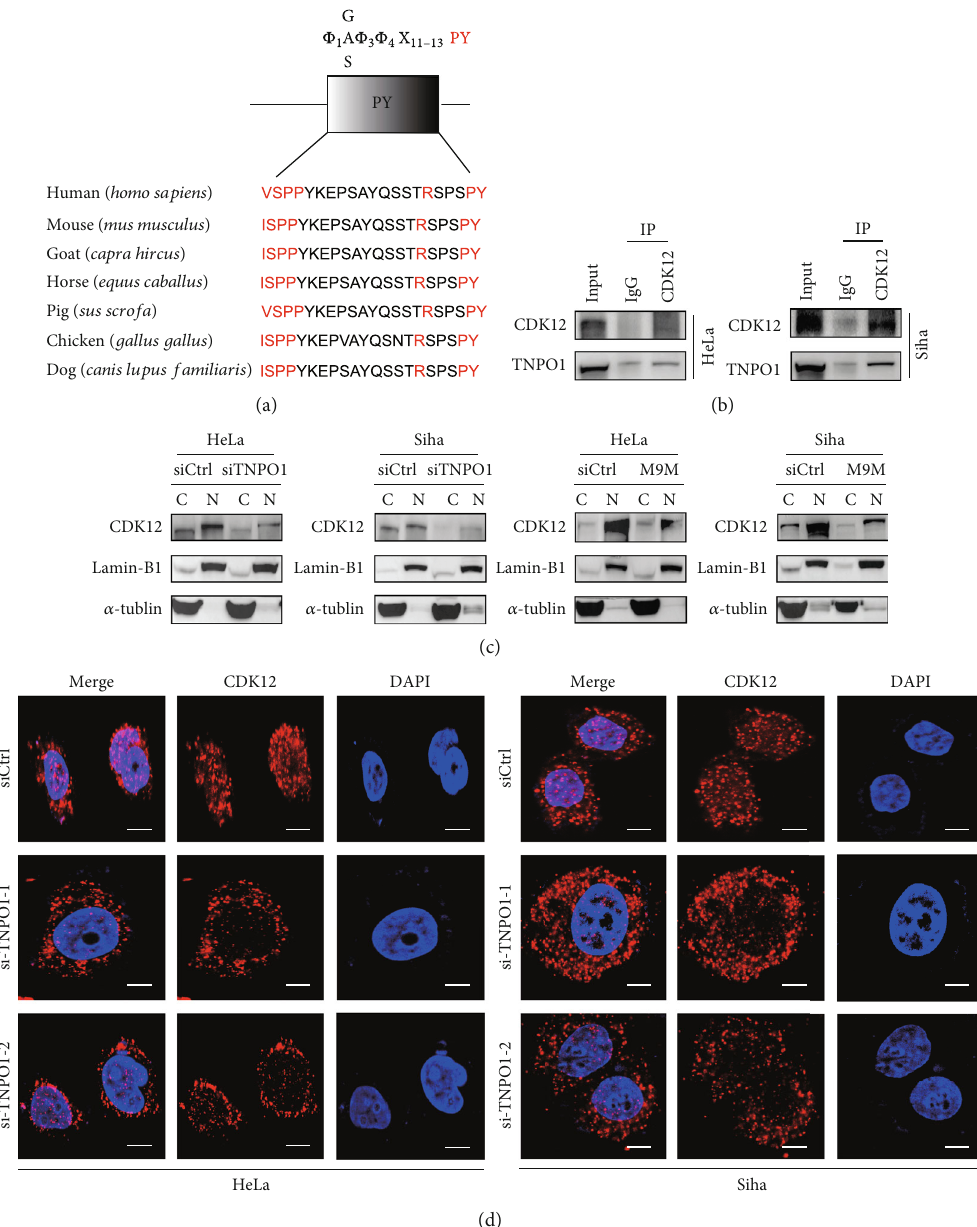
Figure 6: Karyopherin TNPO1 mediates nuclear import of CDK12. (a) PY-motif of the CDK12 of di ff erent species shows that the sequence of this domain is well conserved during evolution; central hydrophobic motifs and the R/K/H-PY motifs are highlighted in red. P: proline; Y: tyrosine. (b) Western blotting of TNPO1 levels following immunoprecipitation of CDK12 in HeLa and Siha cells. (c) After being transfected with siRNA targeting TNPO1 or inhibitor of the TRN pathway (M9M) vector, western blotting of CDK12 levels in the nucleoplasm and cytoplasm of HeLa and Siha cells. (d) HeLa and Siha cells were analyzed by immuno fl uorescence against CDK12, as labeled, during siTNPO1. DAPI staining was used to visualize nuclei. Scale bar: 20 μ